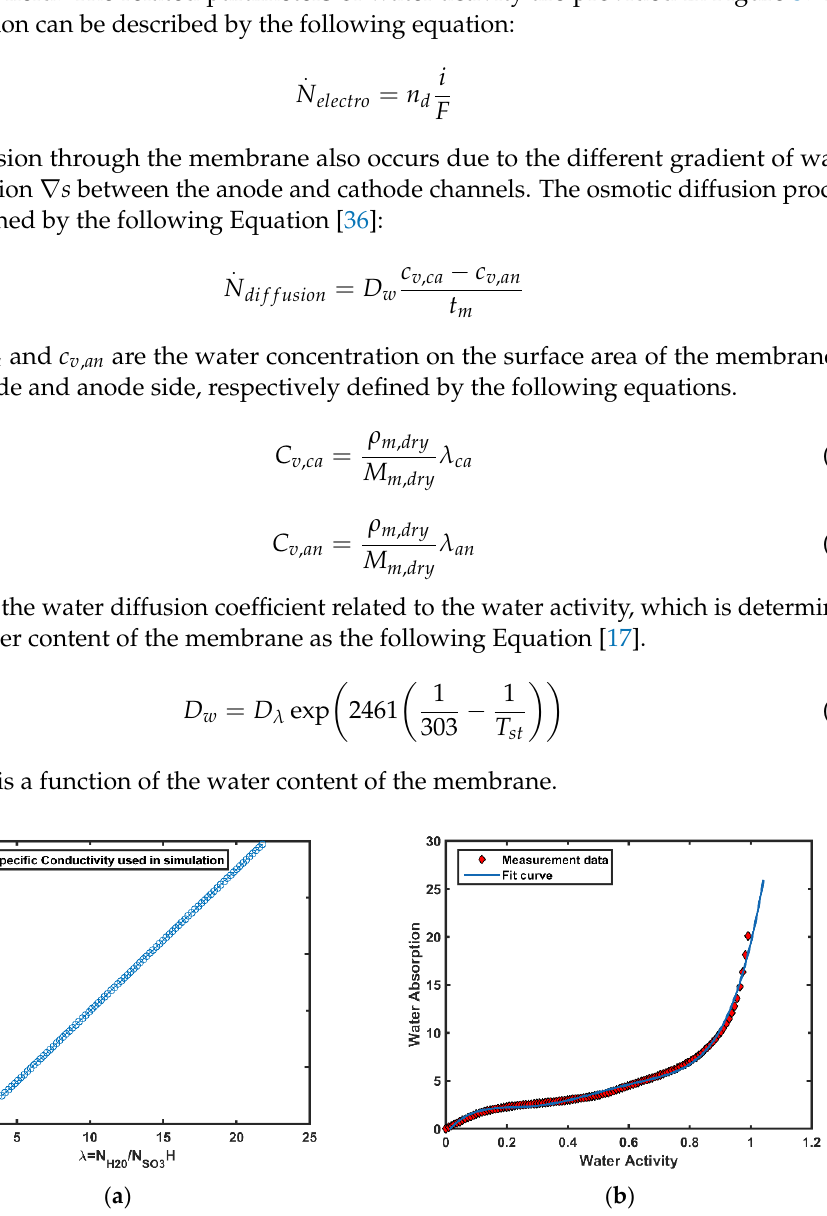
Figure 3. ( a ) The relationship between electrolyte conductivity and water absorption; ( b ) The relationship between water absorption and water activity in ionomers.